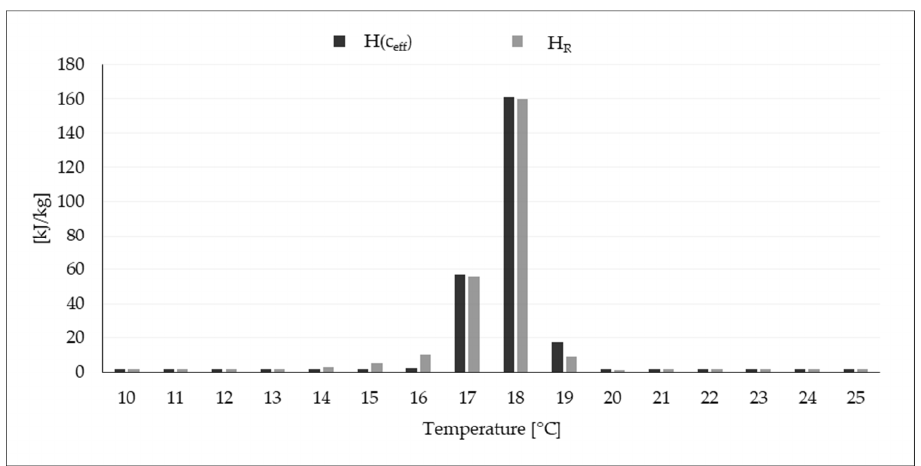
Figure 8. Partial enthalpy attained from c eff and declared by Rubitherm for melting case.